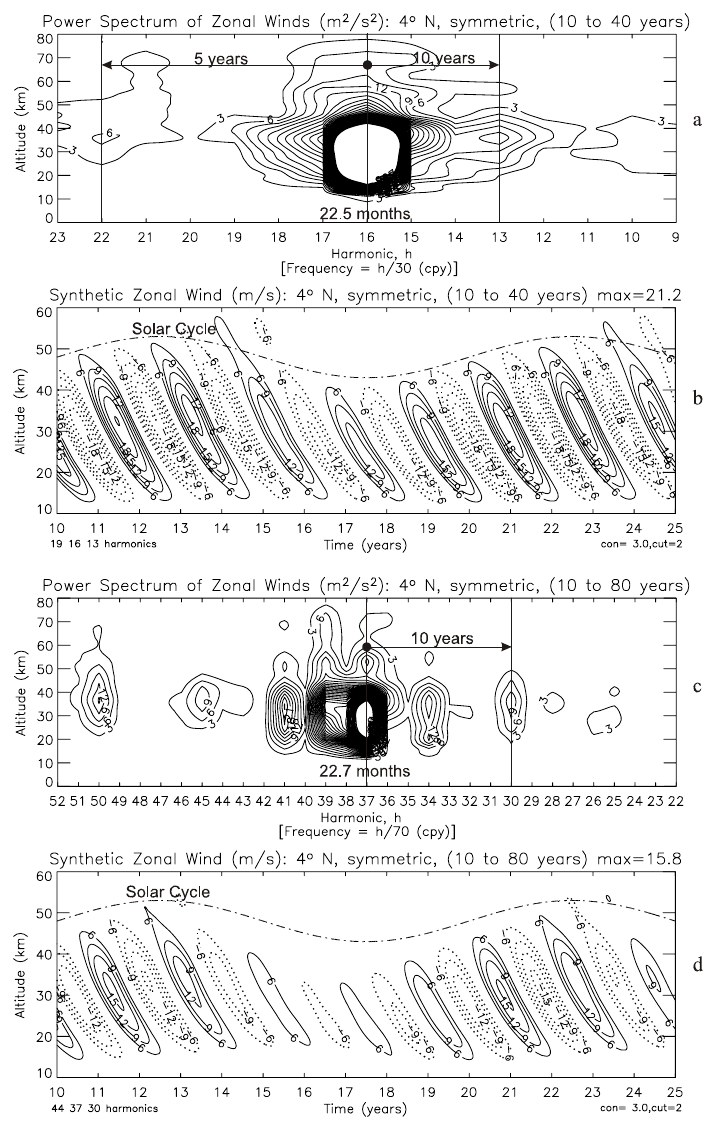
Fig. 4. (a) Power spectrum for the hemispherically symmetric component of the zonal winds, presented in terms of discrete Fourier harmon- ics, h , which are related to the frequency ν =h/y (cpy) in units of cycles per year (y). The time span for the analysis is 30 years, ignoring the first 10 years to account for spin-up. With harmonic h =16, the dominant QBO period is 22.5 months. The side lobe at h =13, removed from the QBO at h =16 by 3 (3rd harmonic of 30 years), thus describes the 10-year SC modulation of the QBO. (Presenting the spectrum in terms of Fourier harmonics allows the SC signatures to be readily identified.) (b) To reveal the SC modulation of the QBO, the dominant QBO harmonic at h =16 is synthesized with the side lobes that describe the 10-year SC signatures, i.e., h =13 (16 − 3) and 19 (16+3), and the harmonics are given at the lower left bottom of the panel. The contour interval is 2m/s and the lowest contours are chosen to be 6m/s to reveal more readily the magnitude of the amplitude modulation. Although the pattern of the QBO modulation is only presented for 15 years, it remains constant and continues to repeat throughout the entire 30-year time span. With dashed line, the phase of the SC forcing is shown for comparison to indicate that the amplitude modulation peaks near the solar maximum. The results are identical to those discussed in Mayr et al. (2006). (c) Analogous to (a) but showing the power spectrum for the model run 10 to 80 years. With the longer time span of 70 years, the spectrum is more complicated and reveals the variability of the QBO. The dominant QBO period is identified at h =37 for a period of 22.7 months. The 10-year SC signature for this period then occurs at h =30 (37 − 7). (d) Similar to (b), the synthesized winds are presented for the SC modulation of the QBO, involving the harmonics h =37 with 37 ± 7. Although the dominant QBO is weaker compared to (b), the SC modulation is comparable in magnitude, and the phase again is close to that of the imposed